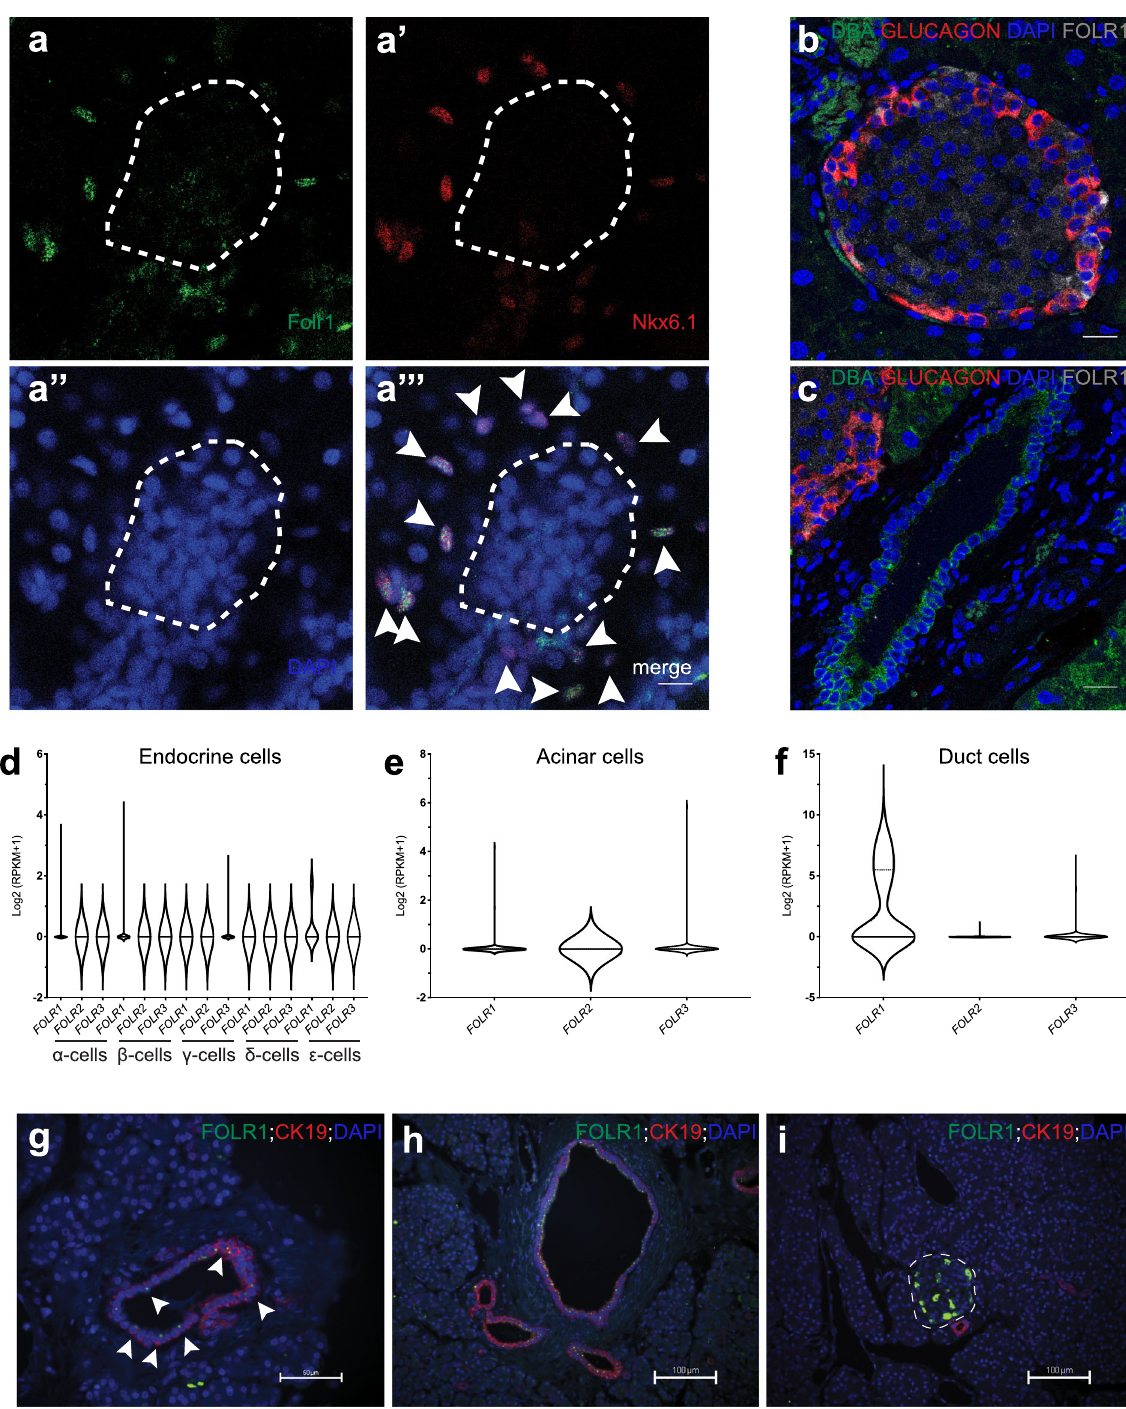
Fig. 3 Expression of Folr1 in the pancreata of different organisms. a – a ”’ , Immunostaining of whole-mount zebra fi sh larvae at 6 dpf using a Folr1 antibody ( a ). Ductal cells were immunostained with the zebra fi sh duct-speci fi c marker Nkx6.1 ( a ’ ), and nuclei were counterstained with DAPI ( a ” ). The white dashed line outlines the islet of the zebra fi sh larvae. Arrowheads ( a ”’ ) point to the Folr1 + ductal cells. Scale bar, 10 μ m. Representative images are shown from one larva. The staining results have been repeated in at least four zebra fi sh larvae and three biological replicates. b , c Representative pictures of an islet ( b ) and a duct ( c ) from adult mouse pancreatic sections immunostained for FOLR1, GLUCAGON ( α -cell marker), and DBA (ductal cell marker) and counterstained with DAPI. Scale bar, 20 μ m. Sections from three biological replicates showed the same expression pattern of FOLR1. d – i Expression of folate receptor homologs in the human pancreas. Violin plots showing single-cell RNA-Seq expression in endocrine ( d ), acinar ( e ), and ductal ( f ) pancreatic cells showed signi fi cant expression of FOLR1 in a subset of duct cells. The expression pattern of FOLR1 found in the single-cell RNA-Seq data was con fi rmed with immuno fl uorescence analysis of human pancreatic sections ( g – i ). The white dashed line outlines the islet in ( i ). Arrowheads in g point to the subset of ductal cells expressing FOLR1, whereas essentially all ductal cells in the large duct in ( h ) are FOLR1 + . Scale bars are indicated on the images. The staining pattern was consistent in pancreata from eight different